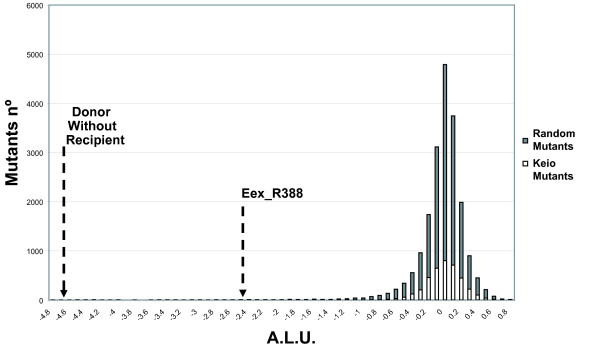
Distribution of mutants ALU values. Distribution of ALU values [ALU = log10 (Light-x/Light-wt)] of the HTS conjugation assay when applied to the 3,908 Keio collection mutants (white bars) or to 20,000 miniTn10::kan insertion mutants (grey bars).